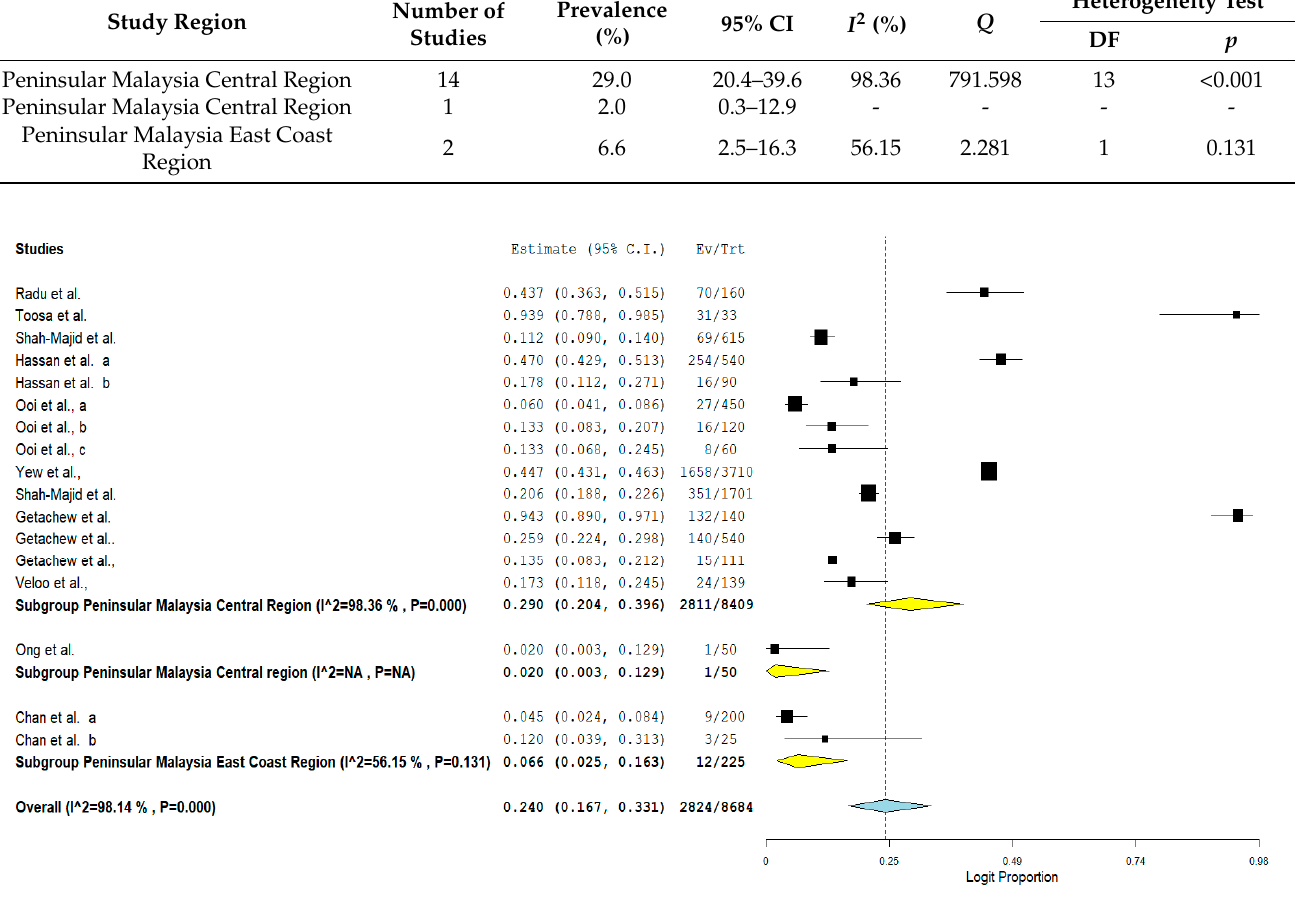
Figure 7. Forest plot showing the subgroup meta-analysis by study region of VRE in poultry in Malaysia.